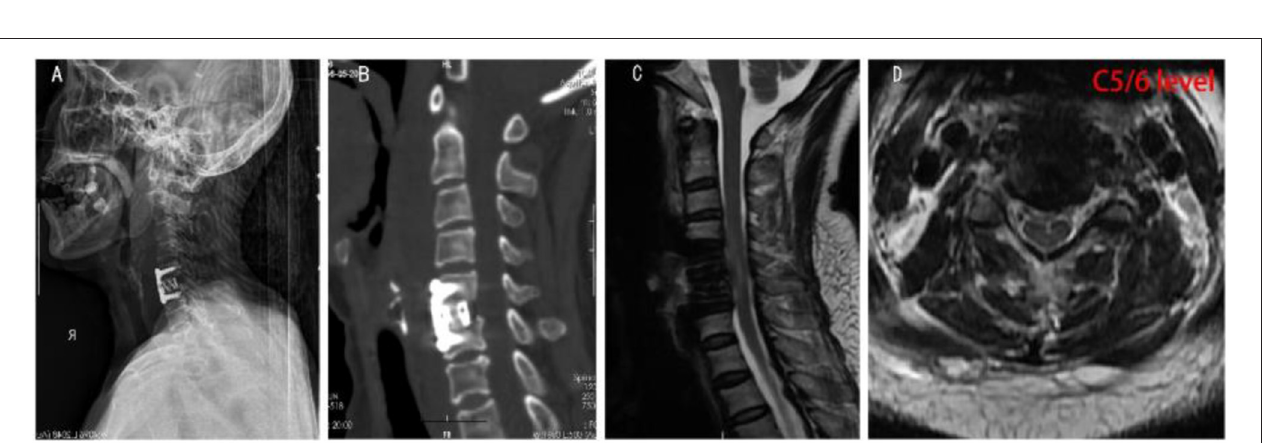
FIGURE 2 | Postoperative imaging results of the patient. (A,B) Postoperative X-ray and CT of the cervical spine showed changes in the C5-6 vertebral body after screw internal fixation, no slippage and fracture were observed, and cage shadow was observed in the C5/6 intervertebral space. (C,D) Postoperative sagittal and transverse MRI of the cervical spine showed internal fixation shadow in the C5-6 vertebrae, showing postoperative changes, with internal fixation in place. No obvious effusion was observed in the C2-T2 prevertebral space.